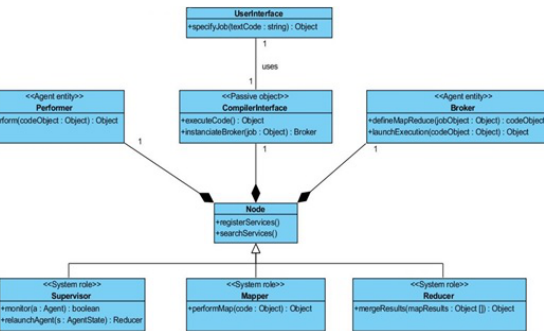
Figure 2: Diagram describes MapReduce tree structure that is formed by peer nodes before reduce operation begins.